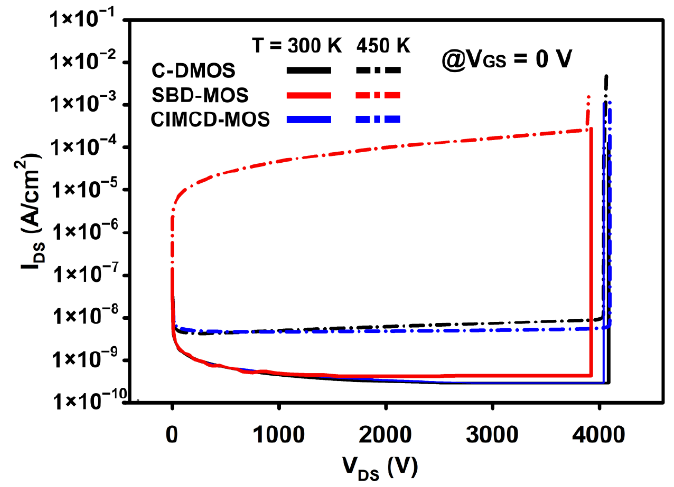
Figure 3. Off-state characteristics of C – DMOSFET, SBD – MOSFET, and CIMCD – MOSFET at T = 300 K and 450 K.